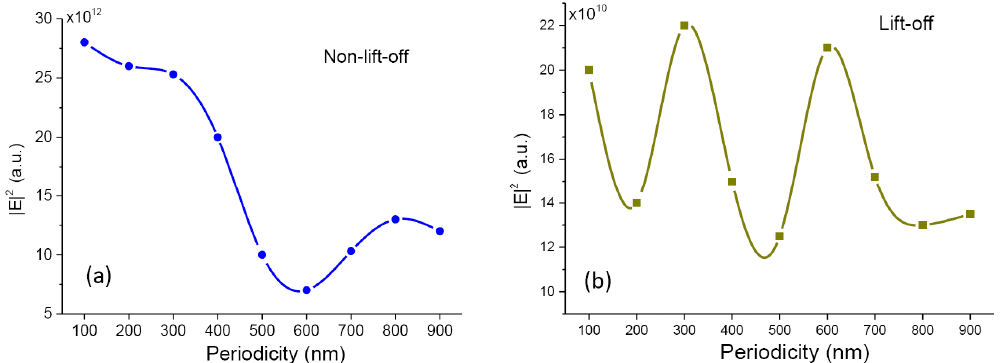
Figure 7. Calculated electrical field intensity on the gold surface of ( a ) non-lift-off and ( b ) lift-off nanogratings. The medium above the gold surface is water. The field strength is averaged over the entire gold surface of a unit cell.